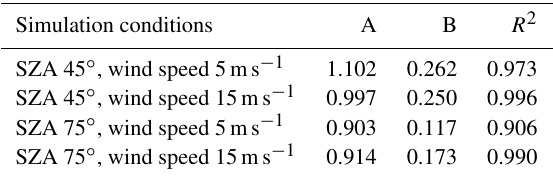
Table 2. Parameters of Eq. (3), which describes the power trend lines in Fig. 4a and